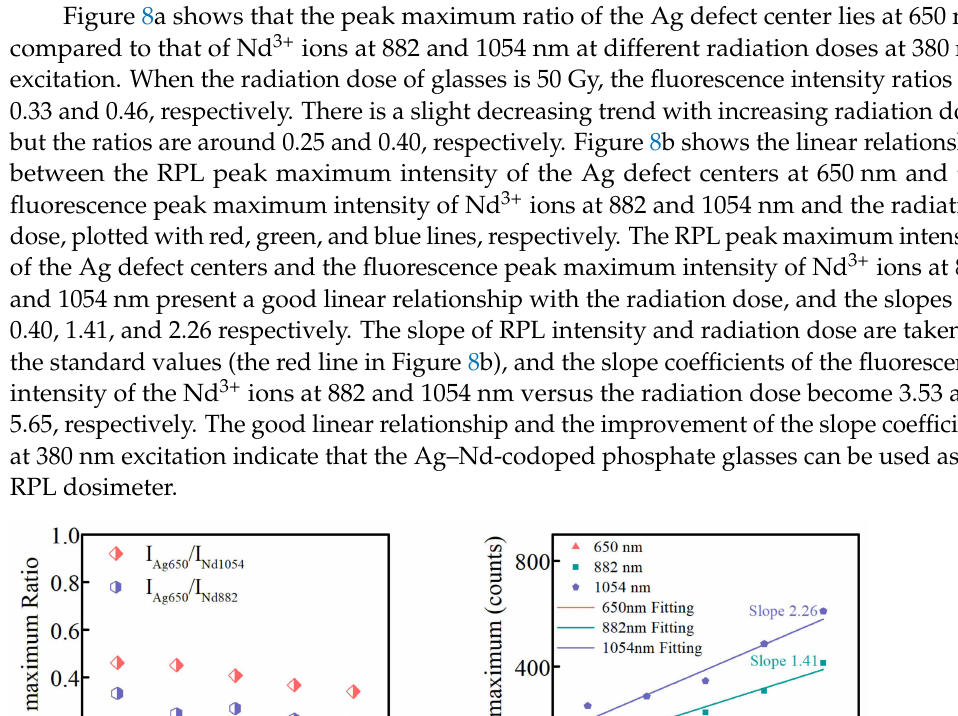
Figure 7. The fluorescence spectra of the Ag–Nd-codoped phosphate glasses at different radiation doses (380 nm excitation).